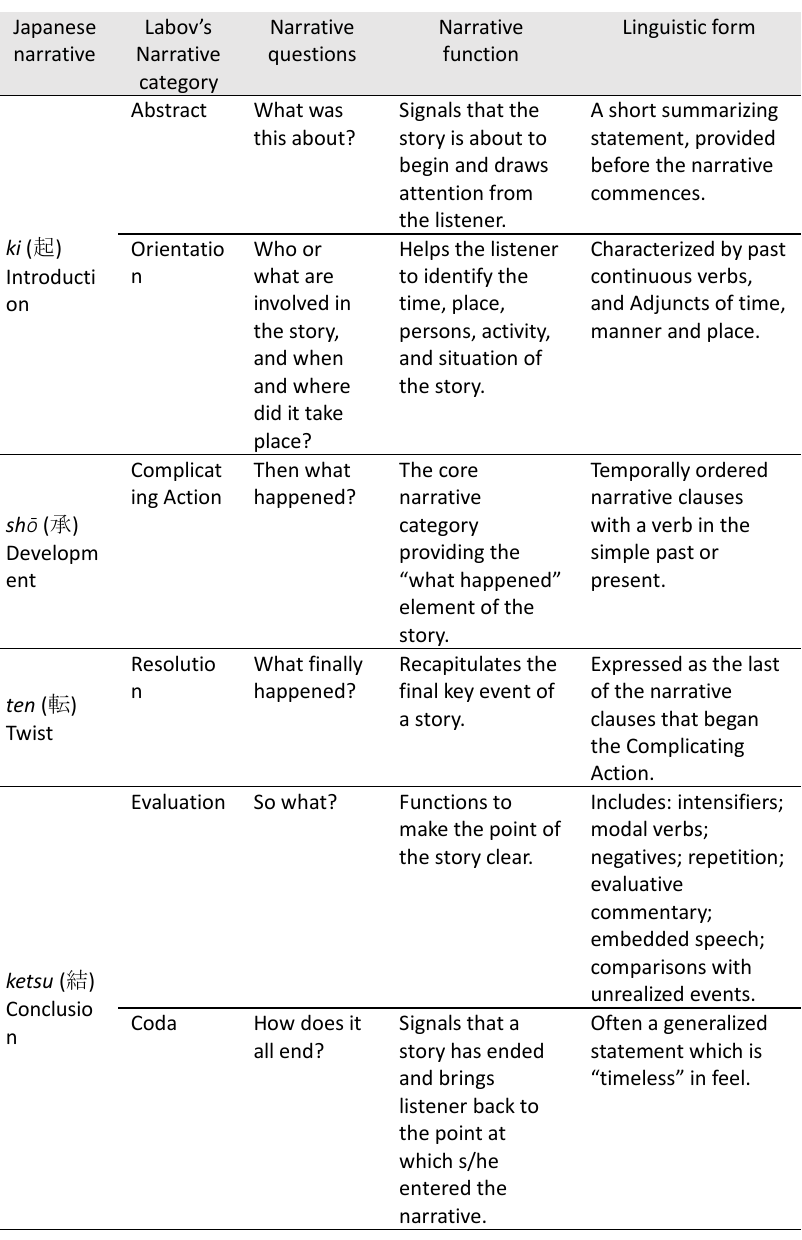
Table 1. The Japanese narrative structure kishōtenketsu aligned with Labov’s